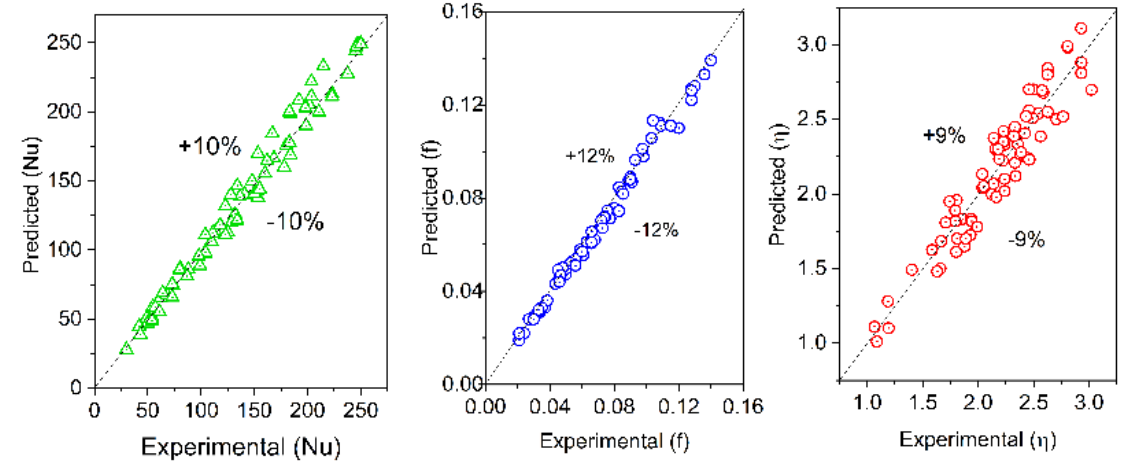
Figure 14. Deviation in predicted and experimental values for ( a ) Nu , ( b ) f and ( c ) η